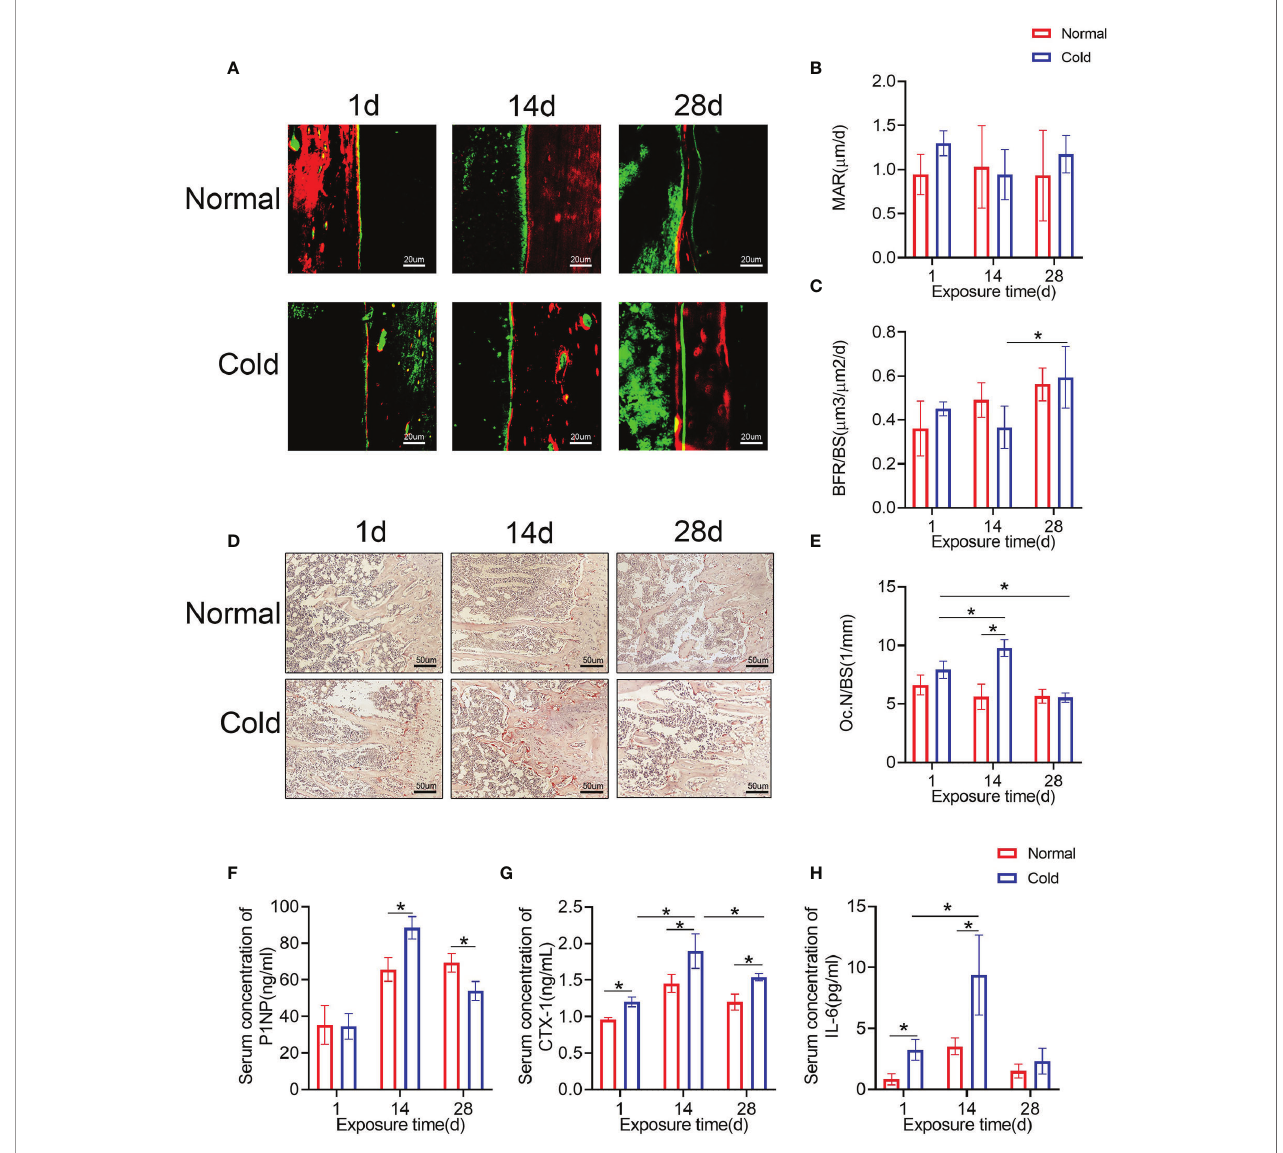
FIGURE 2 | Bone remodeling is in fl uenced by temperature. (A) Calcium and alizarin red double labeling were performed to determine the bone formation rate. (B, C) BFR/BS and MAR shown in A were calculated. (D) Representative TRAP staining of femur bone sections. (E) Histomorphometric quanti fi cation of Oc.N/BS in femur bone. (F – H) CTX-1, P1NP and IL-6 in the serum were detected by ELISA. Black arrows: TRAP positive cells. Data are shown as the mean ± SD (n=5 per group). Signi fi cance (p-value) was calculated using two-way ANOVA, *p < 0.05; 1 day (1 d), 14 days (14 d), 28 days (28 d), Normal: mice at room temperature (23°C), Cold: mice at